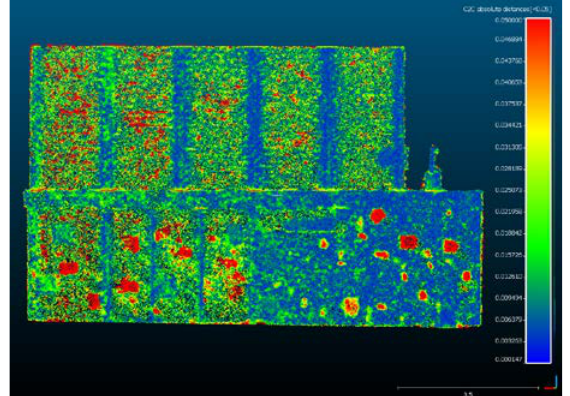
Figure 3. Colour map of distances between the photogrammetric models of T1.1 and T1.2 at the absolute maximum distance of 5 cm.